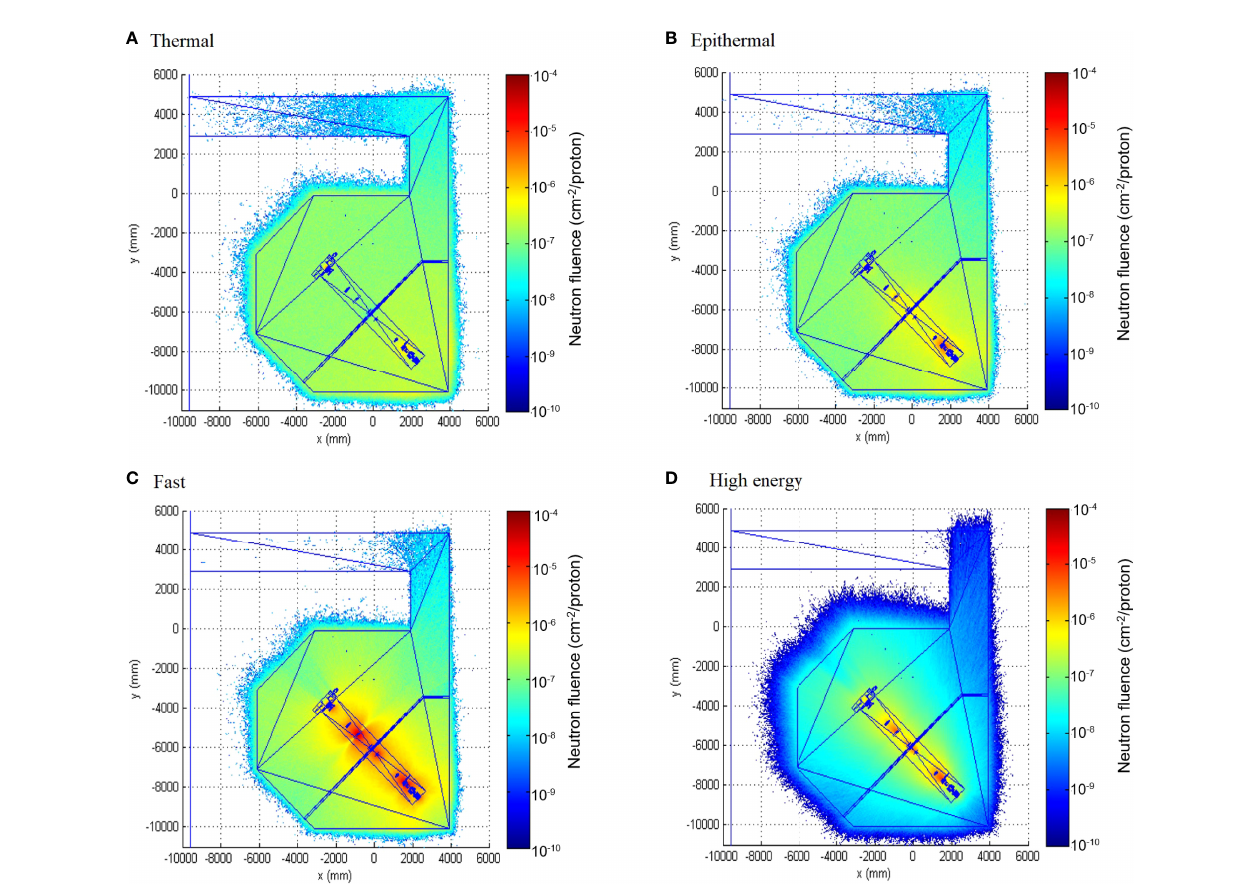
FIGURE 4 | Neutron fl uence map inside the facility for the four relevant groups: thermal (E < 0.4 eV) ( A ), epithermal (0.4 eV < E < 0.1 MeV) ( B ), fast (0.1 MeV< E < 20 MeV) ( C ) and high energy (20 MeV < E < 200 MeV) ( D